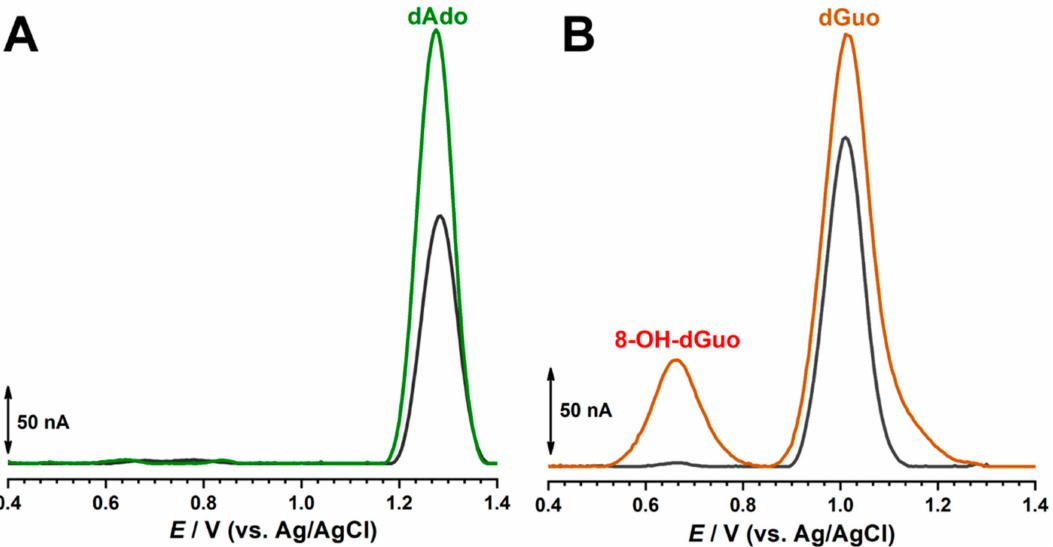
Figure 7. DP voltammograms in acetate buffer (0.1 M, pH 4.5) with different biosensors: ( A ) poly(A) and ( B ) poly(G) biosensors before (grey curves) and after incubation (green and orange curves, respectively) in 500 µ M AZA over 10